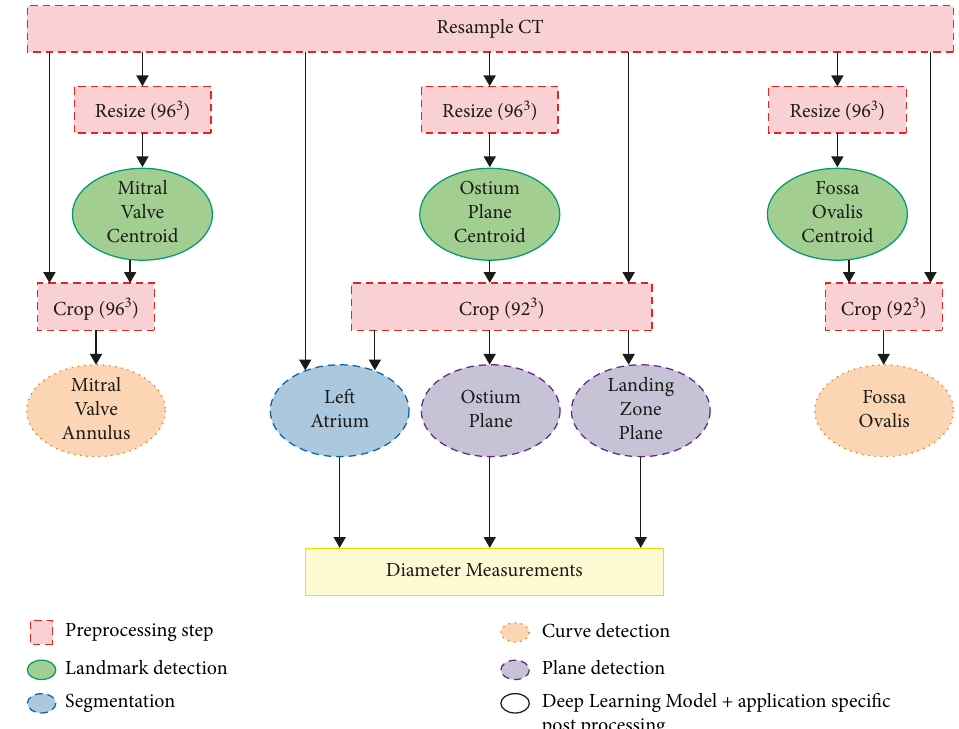
Figure 2: Overview of the steps included in the complete